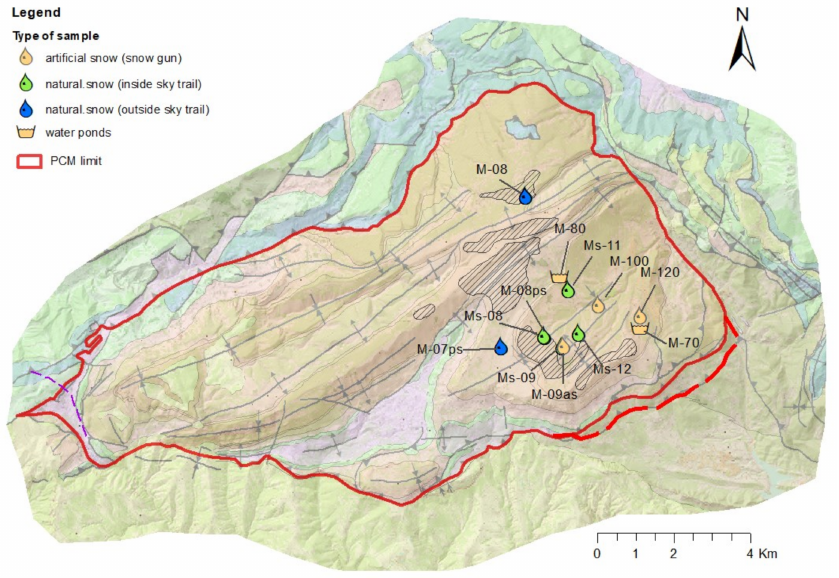
Figure A4. Map of the sampling points for the 10 snow samples (7 natural and 3 artificial) and 2 water ponds.